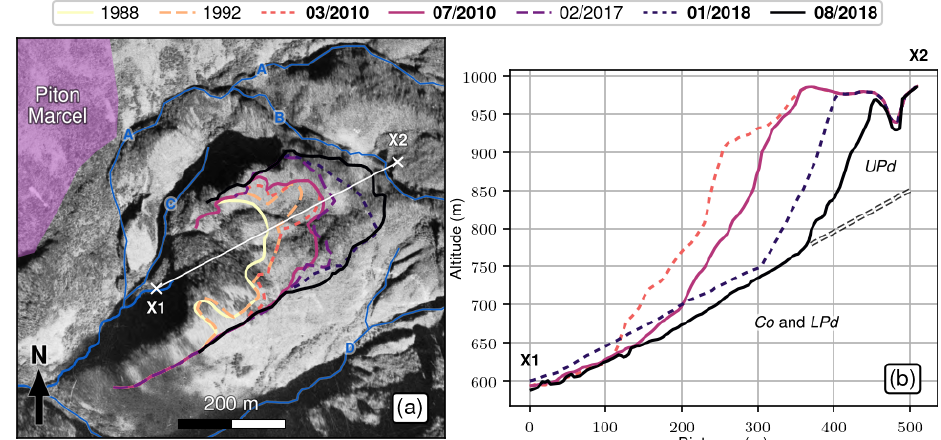
Figure 2. Evolution of the Samperre cliff between 1951 and 2018. (a) 1951 ortho-photograph of the Samperre cliff. The successive cliff rims observed in ortho-photographs and DEMs between 1988 and 2018 are given by plain and dashed lines. The Samperre river (thick blue line), ravines (thin blue lines) and the Piton Marcel (purple patch) are given as in Fig. 1. (b) Successive cross-sections of the cliff (March 2010, July 2010, January 2018, August 2018, in bold in the legend). The inferred contact between the stable unit UPd and unstable units Co and LPd is given by the dashed white line. The extent of the cross-section is reported in (a) by the segment [ X 1 ,X 2].